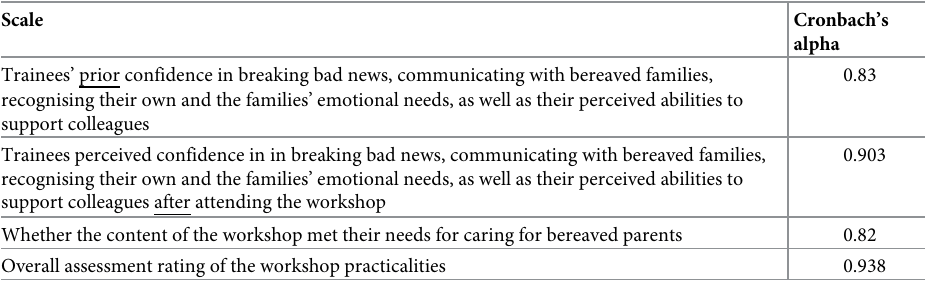
Table 3. Internal consistency for each of the Likert